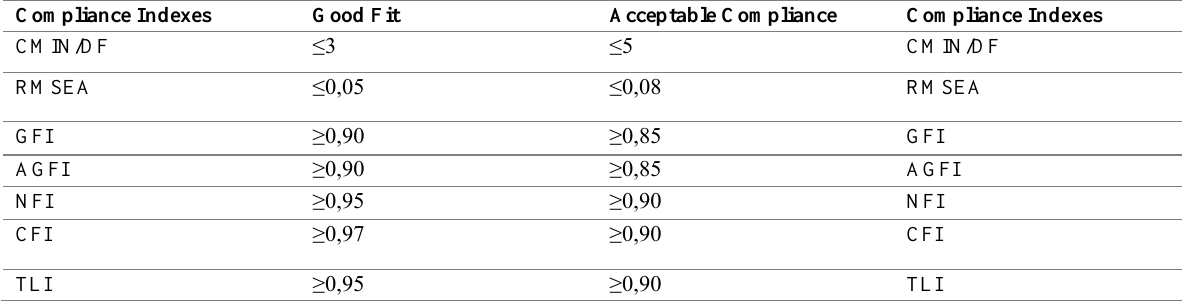
Table 2: CFA Goodness of fit of value criteria